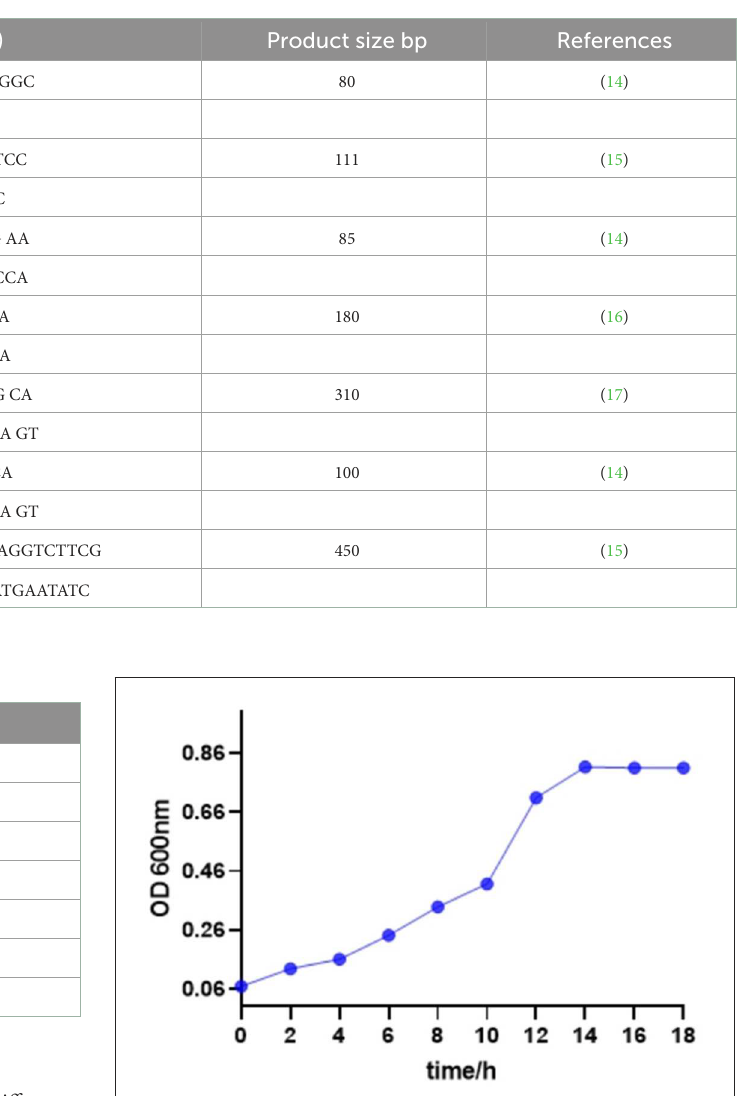
TABLE 3 Primer sequence used for real-time RT-PCR.